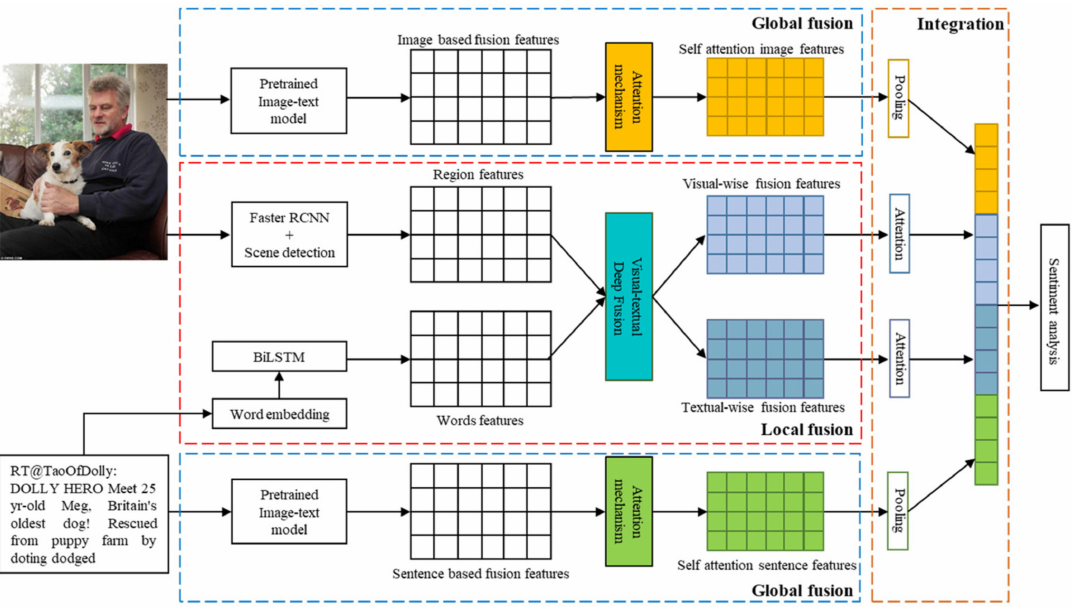
Figure 2. The overall framework of proposed